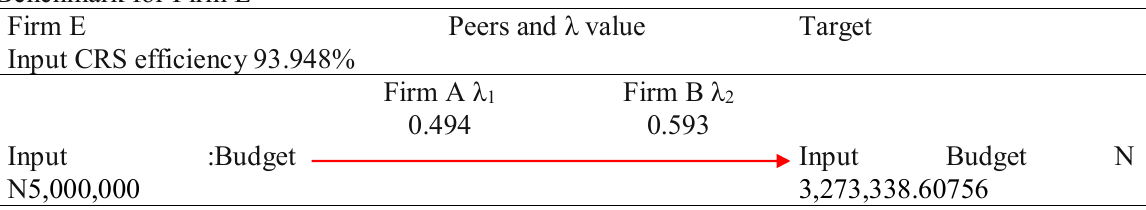
Benchmark for Firm